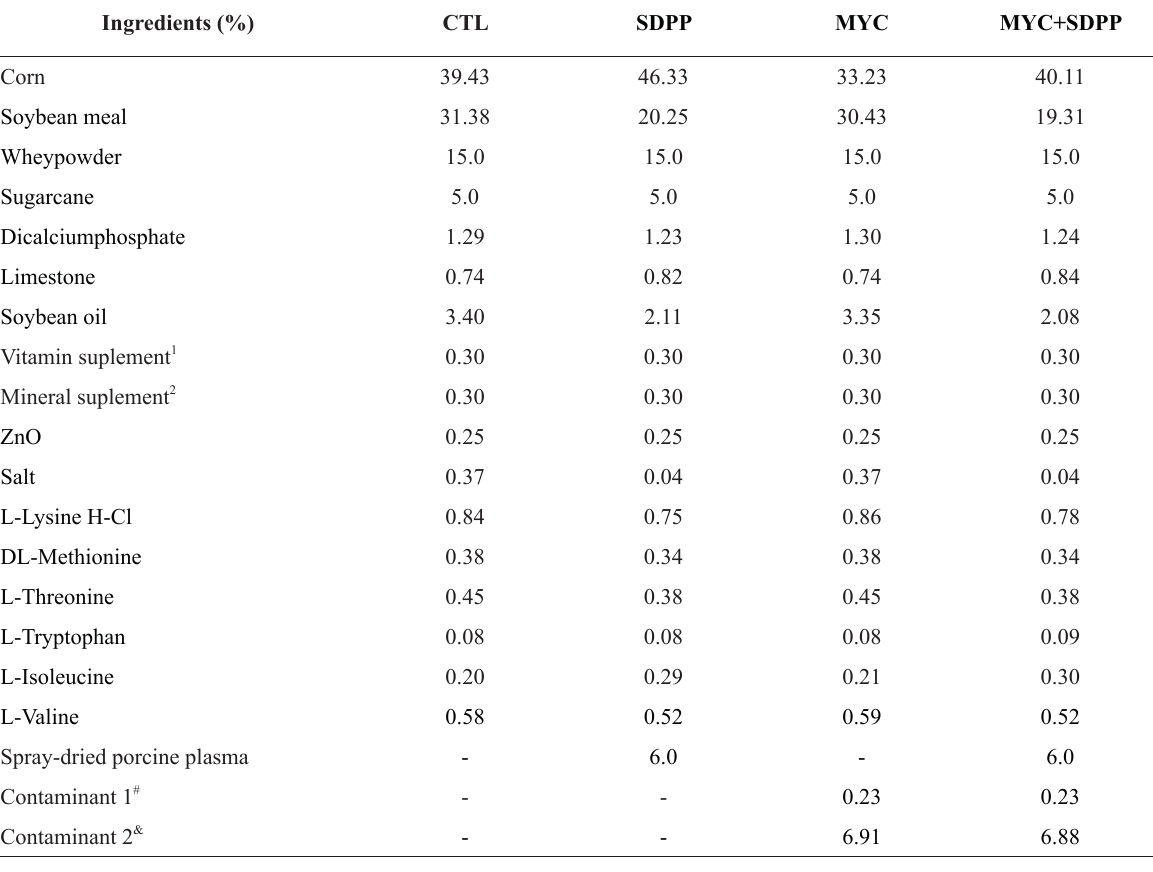
Ingredients of experimental diets. CTL: control diet; SDPP: control diet and SDPP; MYC: control diet and mycotoxins addition; MYC+SDPP: mycotoxins addition and